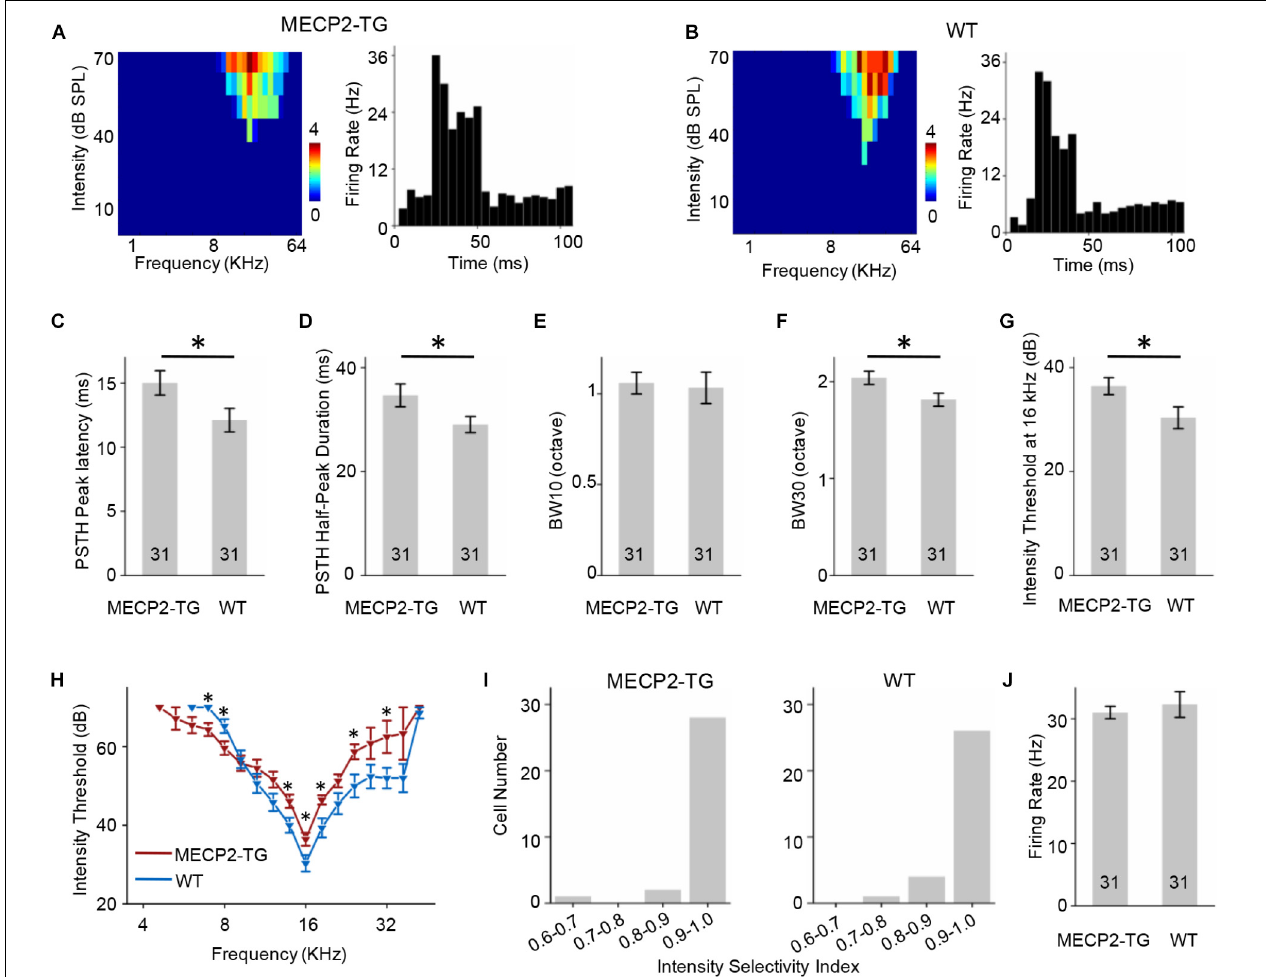
FIGURE 4 | (A,B) Left, representative tonal receptive field (TRF) of a regular-spiking (RS) neuron. Right, representative peri-stimulus spike time histogram (PSTH) of an RS neuron. (C) Averaged peak latency of RS neurons recorded from MECP2-TG mice and wild-type (WT) mice, respectively. ∗ p < 0.05, t -test, mean ± standard error of the mean (SEM). (D) Averaged duration at the half-maximum level in the PSTHs of RS neurons recorded from MECP2-TG mice and WT mice, respectively. ∗ p < 0.05, t -test, mean ± SEM. (E,F) Average tuning bandwidth of TRFs at 10 and 30 dB above the intensity threshold of RS neurons recorded from MECP2-TG mice and WT mice. ∗ p < 0.05, t -test, mean ± SEM. (G) Average intensity threshold at characteristic frequency (CF, 16 kHz) in RS neurons recorded from MECP2-TG mice and WT mice, respectively. ∗ p < 0.05, t -test, mean ± SEM. (H) Average intensity threshold for each frequency tested all along the tuning curve in RS neurons recorded from MECP2-TG mice and WT mice, respectively. (I) Distribution of intensity selectivity indices of RS neurons recorded from MECP2-TG mice and WT mice, respectively. Bin size = 0.1. (J) Averaged activity of RS neurons to best frequency (BF) ± 0.2 octave at 70 dB. t -test, mean ±